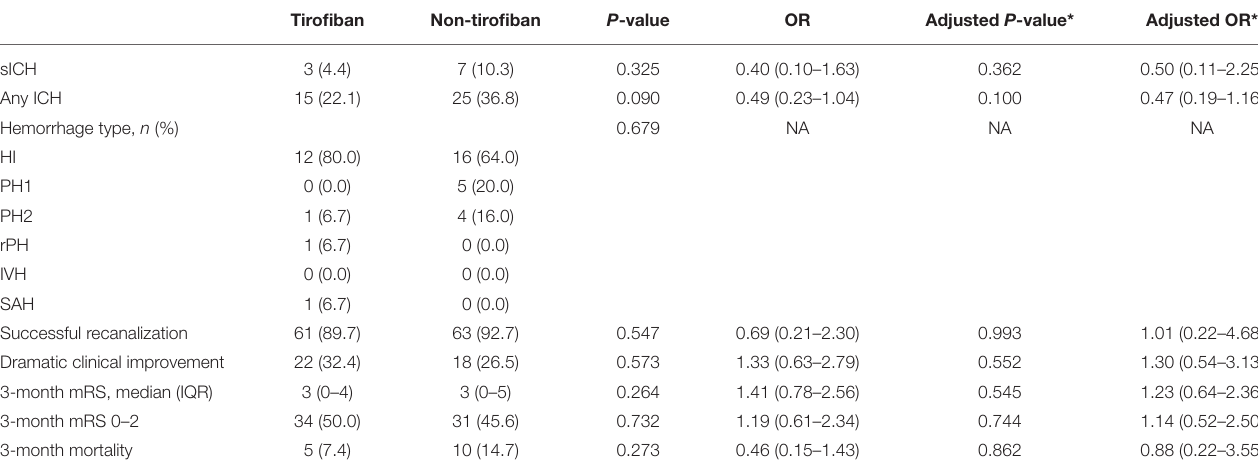
TABLE 4 | Safety and efficacy endpoints of MT patients with preceding intravenous thrombolysis after PSM. Tirofiban